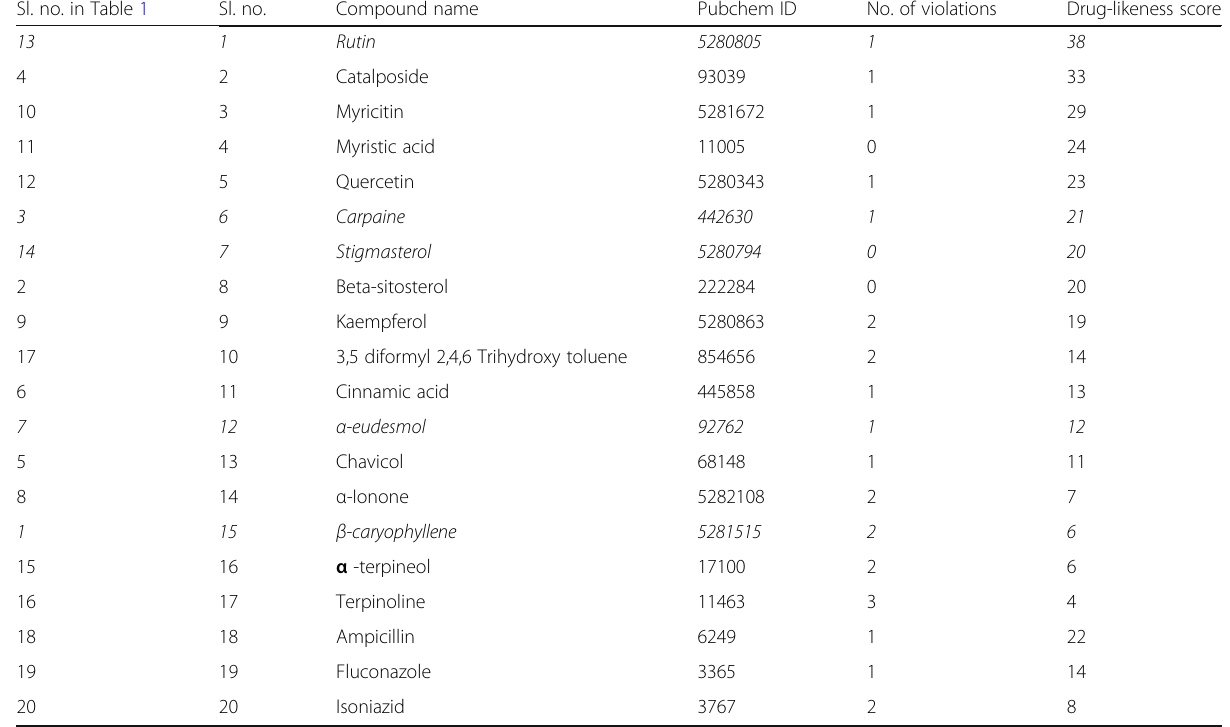
Table 2 Drug-likeness score of different phytochemicals based on Lipinski rule Sl. no. in Table 1 Sl.